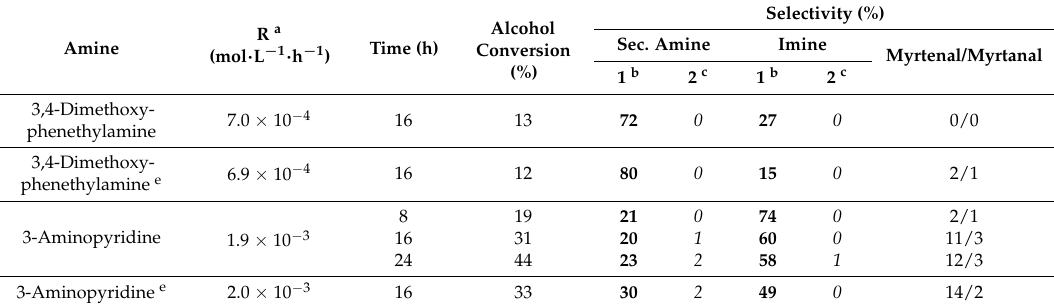
Table 14. Allylic amination of terpenes with sulfonimidamide S*NH 2 ( 1 in Figure. 28) a . Adapted from [143].